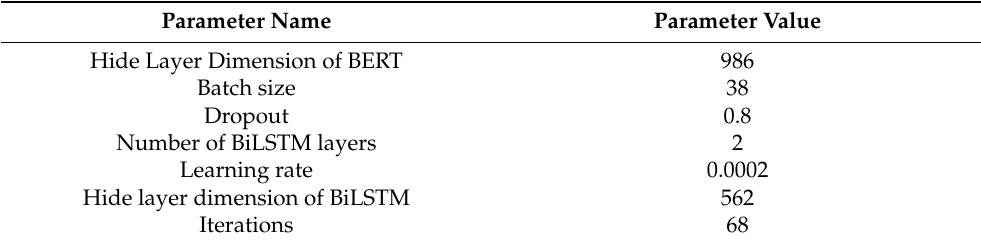
Table 9. The super parameters of experiment.